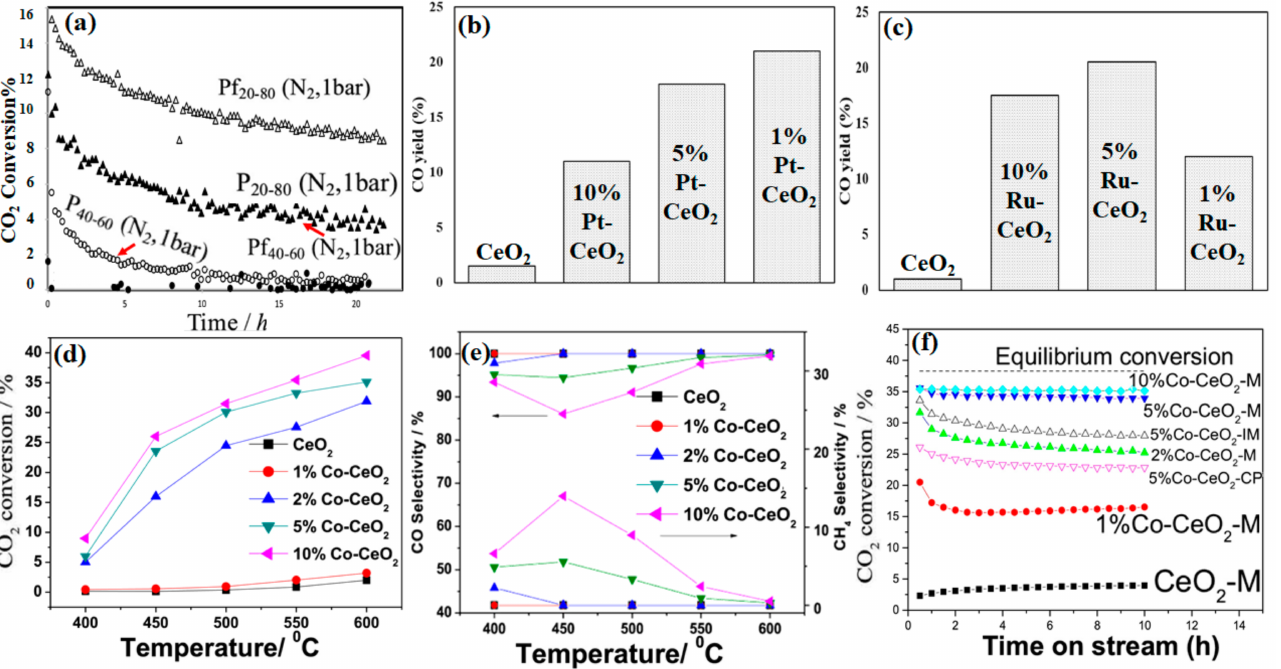
Figure 14. Effect of metal loading on metal-CeO 2 RWGS reaction: ( a ) CuO x -CeO 2 , adapted